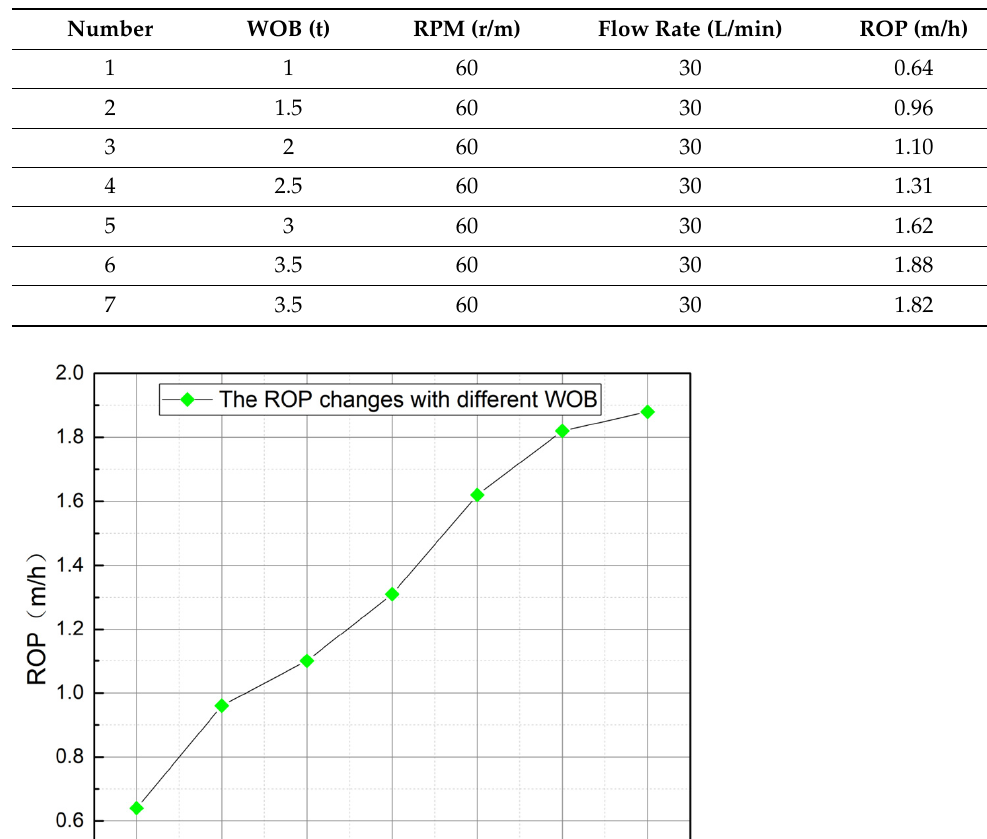
Table 5. Statistics on bit drilling efficiency of bionic core bit.